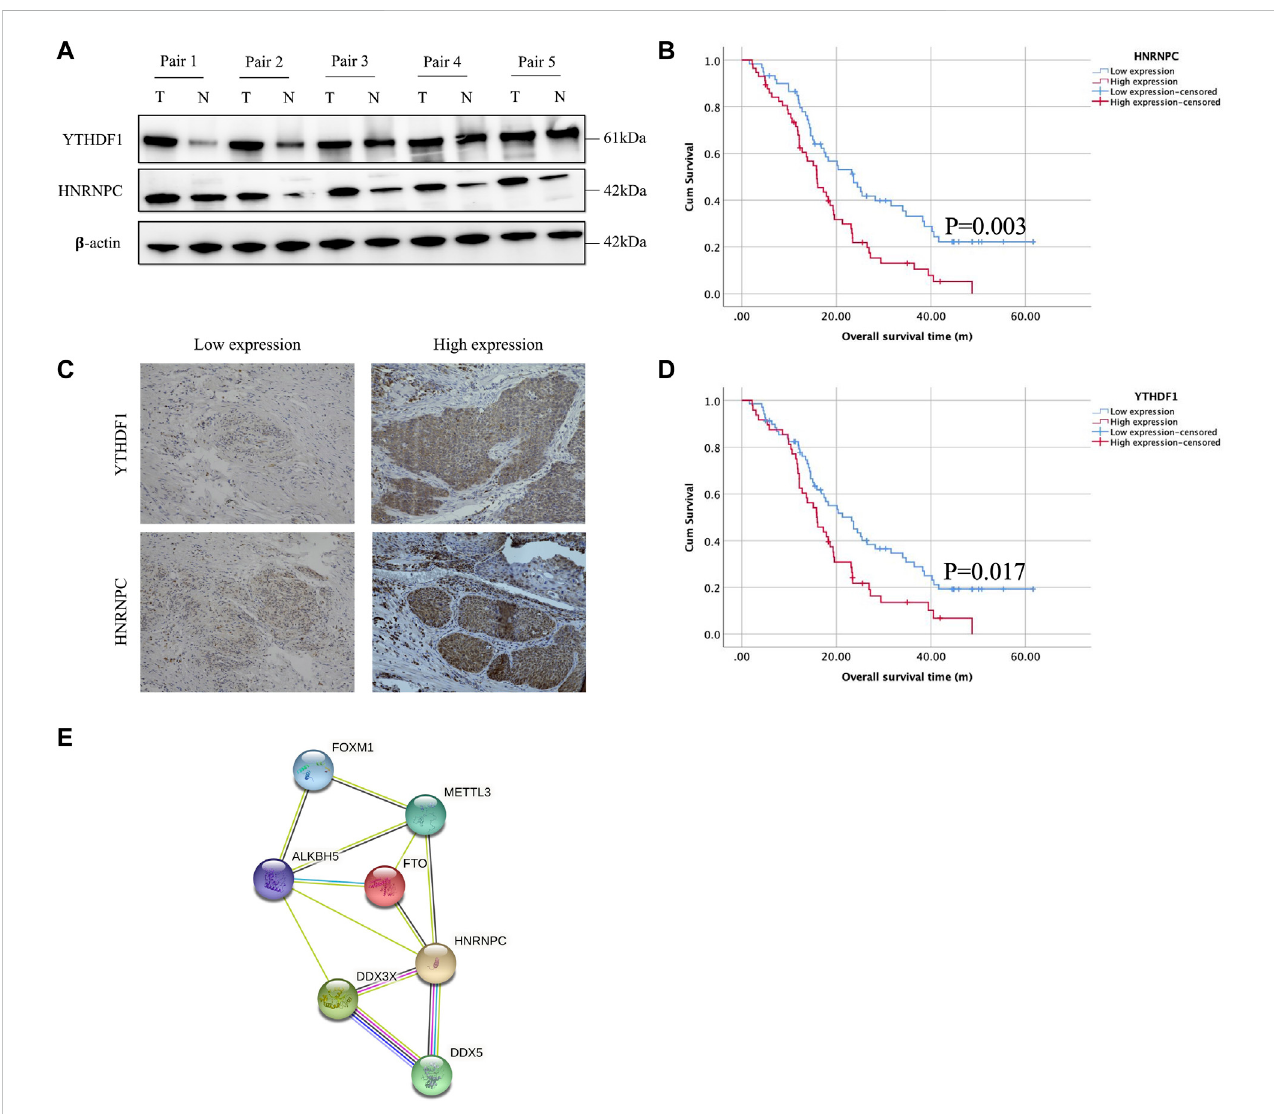
FIGURE 6 ExperimentalvalidationofYTHDF1andHNRNPCwithWesternblot,immunohistochemicalstainingandPPInetworkanalysis. (A) Westernblotanalysisof YTHDF1 and HNRNPC expression in 5 pairs of fresh frozen ESCC specimens with related adjacent normal tissues. (B) Representative immunohistochemical images of YTHDF1 and HNRNPC expression in ESCC tissues (scale bar: 50 μ m). (C) Kaplan-Meier analysis for patients with high or low expression levels of YTHDF1 and HNRNPC from ESCC tissue sections. (D) PPI network showed the interactions between HNRNPC and other m6A RNA methylation regulators. Data are shown as the means ± SD. * p < 0.05. ESCA, esophageal squamous cell carcinoma; TCGA, The Cancer Genome Atlas; HNRNPC, RNA- binding protein, is a member of the heterogeneous ribonucleoproteins C; YTHDF1, YTH N6-methyladenosine RNA-binding protein 1; METTL3, Methyltransferase-like